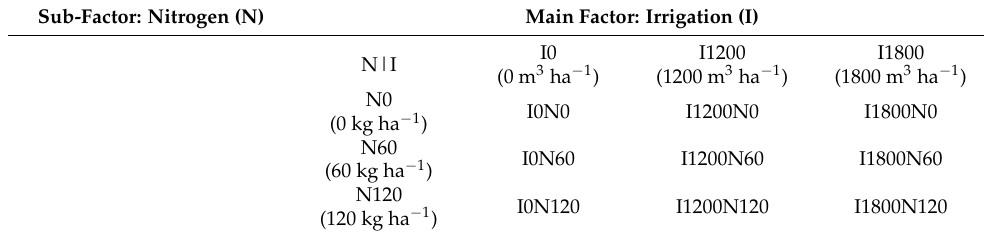
Table 6. Split-plot